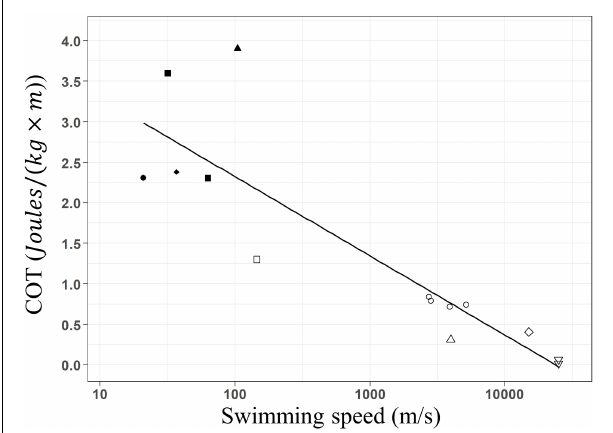
FIGURE 5 | Linear regression between the estimated optimal mass-specific cost of transport and mass of cetacean species. California sea lion Zalophus californianus ( • : Fedak and Seeherman, 1979; Williams et al., 1991; Williams, 1999), Harbor seal Phoca vitulina ( (cid:4) : Davis et al., 1985; Williams et al., 1991), Harbor porpoise Phocoena phocoena ( (cid:7) : Otani et al., 2001), gray seal Halichoerus grypus ( (cid:78) : Fedak and Seeherman, 1979), Bottlenose dolphin Tursiops truncatus ( (cid:3) ; Williams et al., 1993), Killer whale Orcinus orca ( (cid:13) : Kriete, 1995; Williams and Noren, 2009), Minke whale